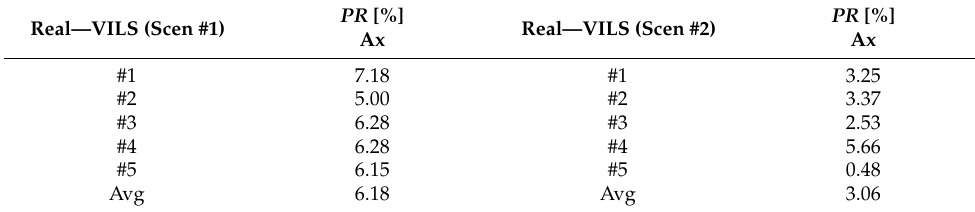
Table 5. Data Comparison Result—Longitudinal acceleration